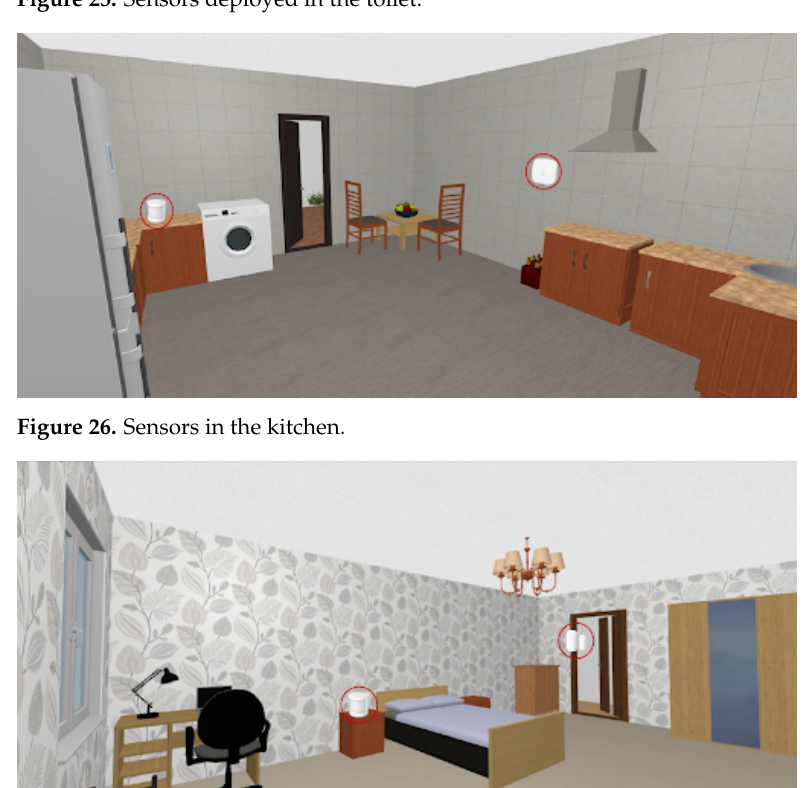
Figure 25. Sensors deployed in the toilet.